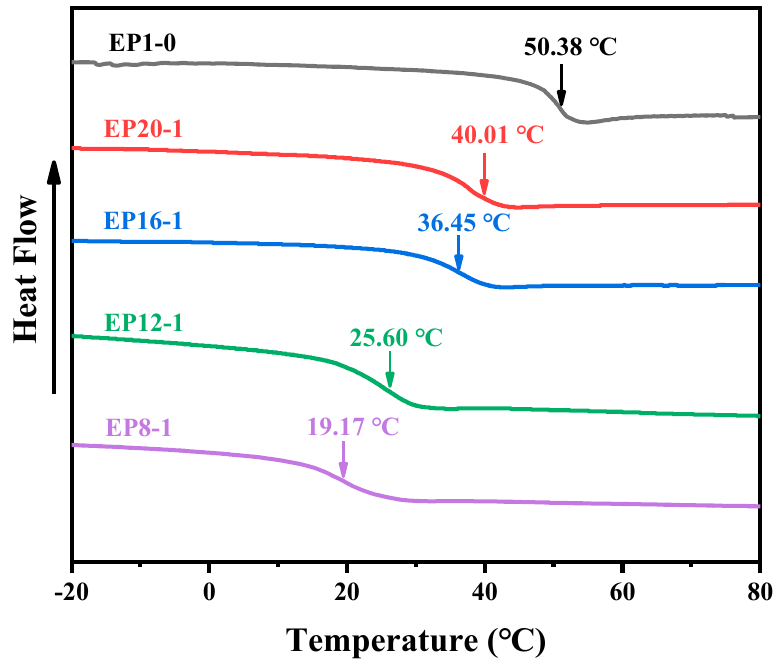
Figure 6. The second heating curve of EPx samples.